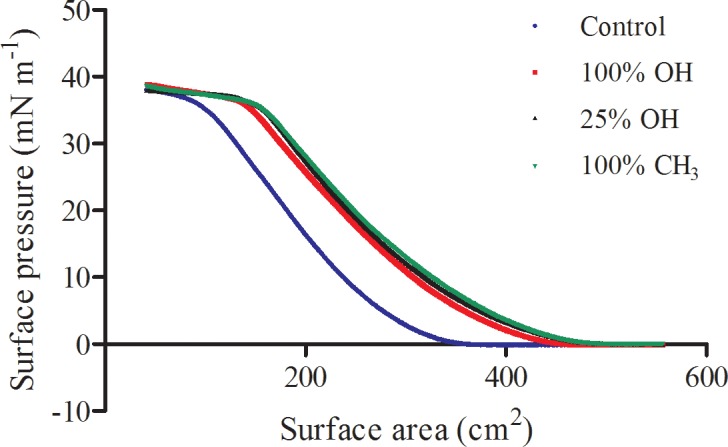
Surface pressure versus surface area isotherms of monolayers containing DPPC and G6Pase, in the absence (control) or presence of nAu.Control (blue), nAu functionalized with 100% OH (red), nAu functionalized with 25% OH (black), nAu functionalized with 100% CH3 (green).